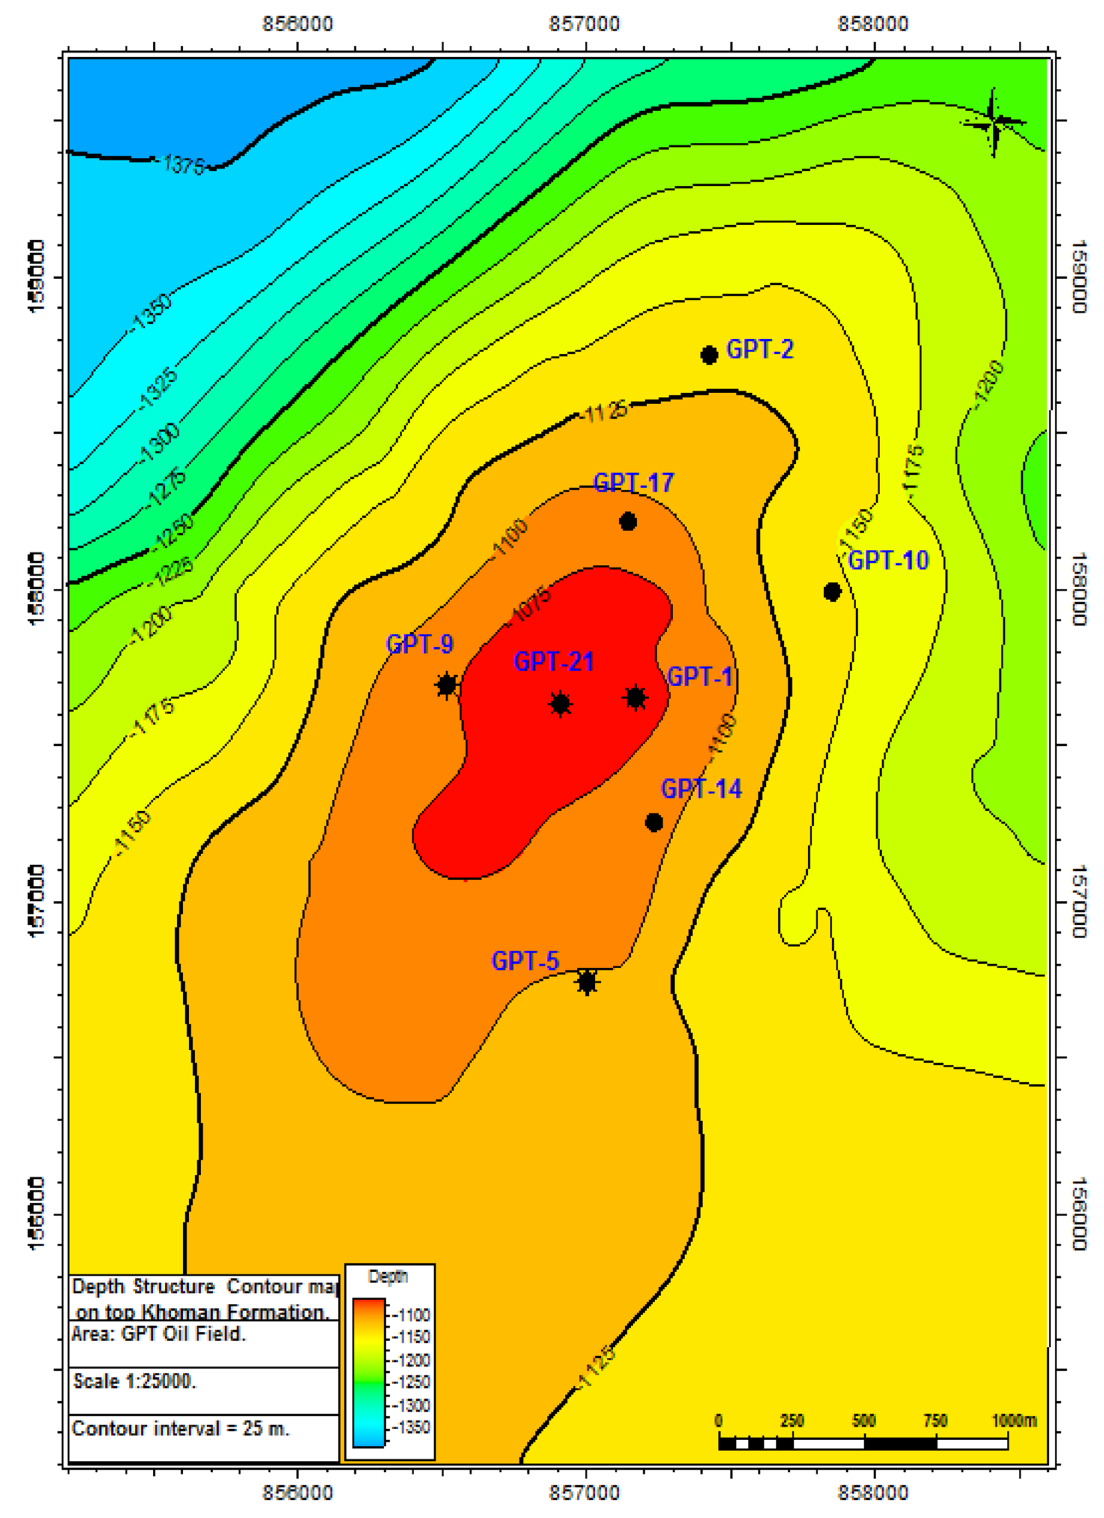
Fig. 9 Depth structure contour map of top of the Khoman